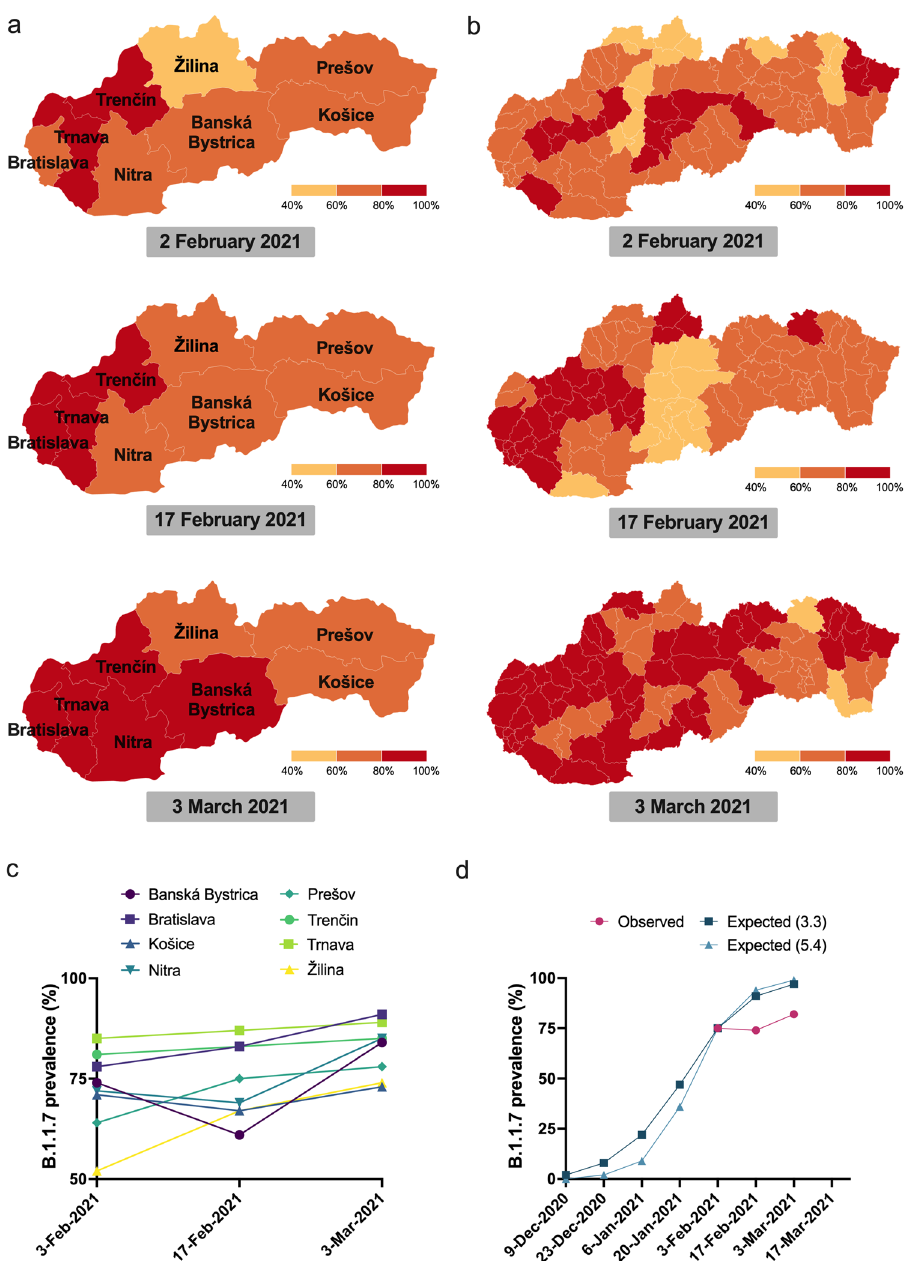
Figure 3. Tracking the prevalence of lineage B.1.1.7 in Slovakia. ( a ) Maps of the prevalence of lineage B.1.1.7 in the eight regions of Slovakia during the three screening rounds held on February 2nd, 2021, February 17th, 2021, and March 3rd, 2021. Regions in red have prevalence > 80%, regions in yellow have prevalence < 60%. ( b ) Maps of the prevalence of lineage B.1.1.7 in the 79 districts of Slovakia during the three screening rounds held on February 2nd, 2021, February 17th, 2021, and March 3rd, 2021. Regions in red have prevalence > 80%, regions in yellow have prevalence < 60%. ( c ) Trends in B.1.1.7 prevalence during the three screening rounds in each of the eight regions of Slovakia. ( d ) Observed trends in B.1.1.7 prevalence during the three screening rounds and expected prevalence given various 2-week spread factors (shown in parentheses) assuming the prevalence of February 2nd, 2021. The prevalence maps in sections ( a,b ) were generated using Datawrapper (https:// www. dataw rapper. de/) in version